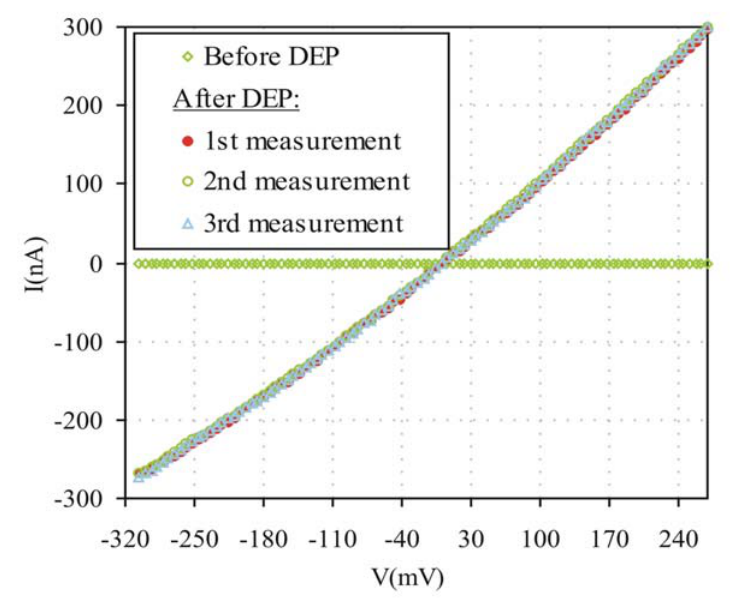
Figure 5. Current voltage characteristics of the SWCNTs assembled onto CMOS circuitry by DEP